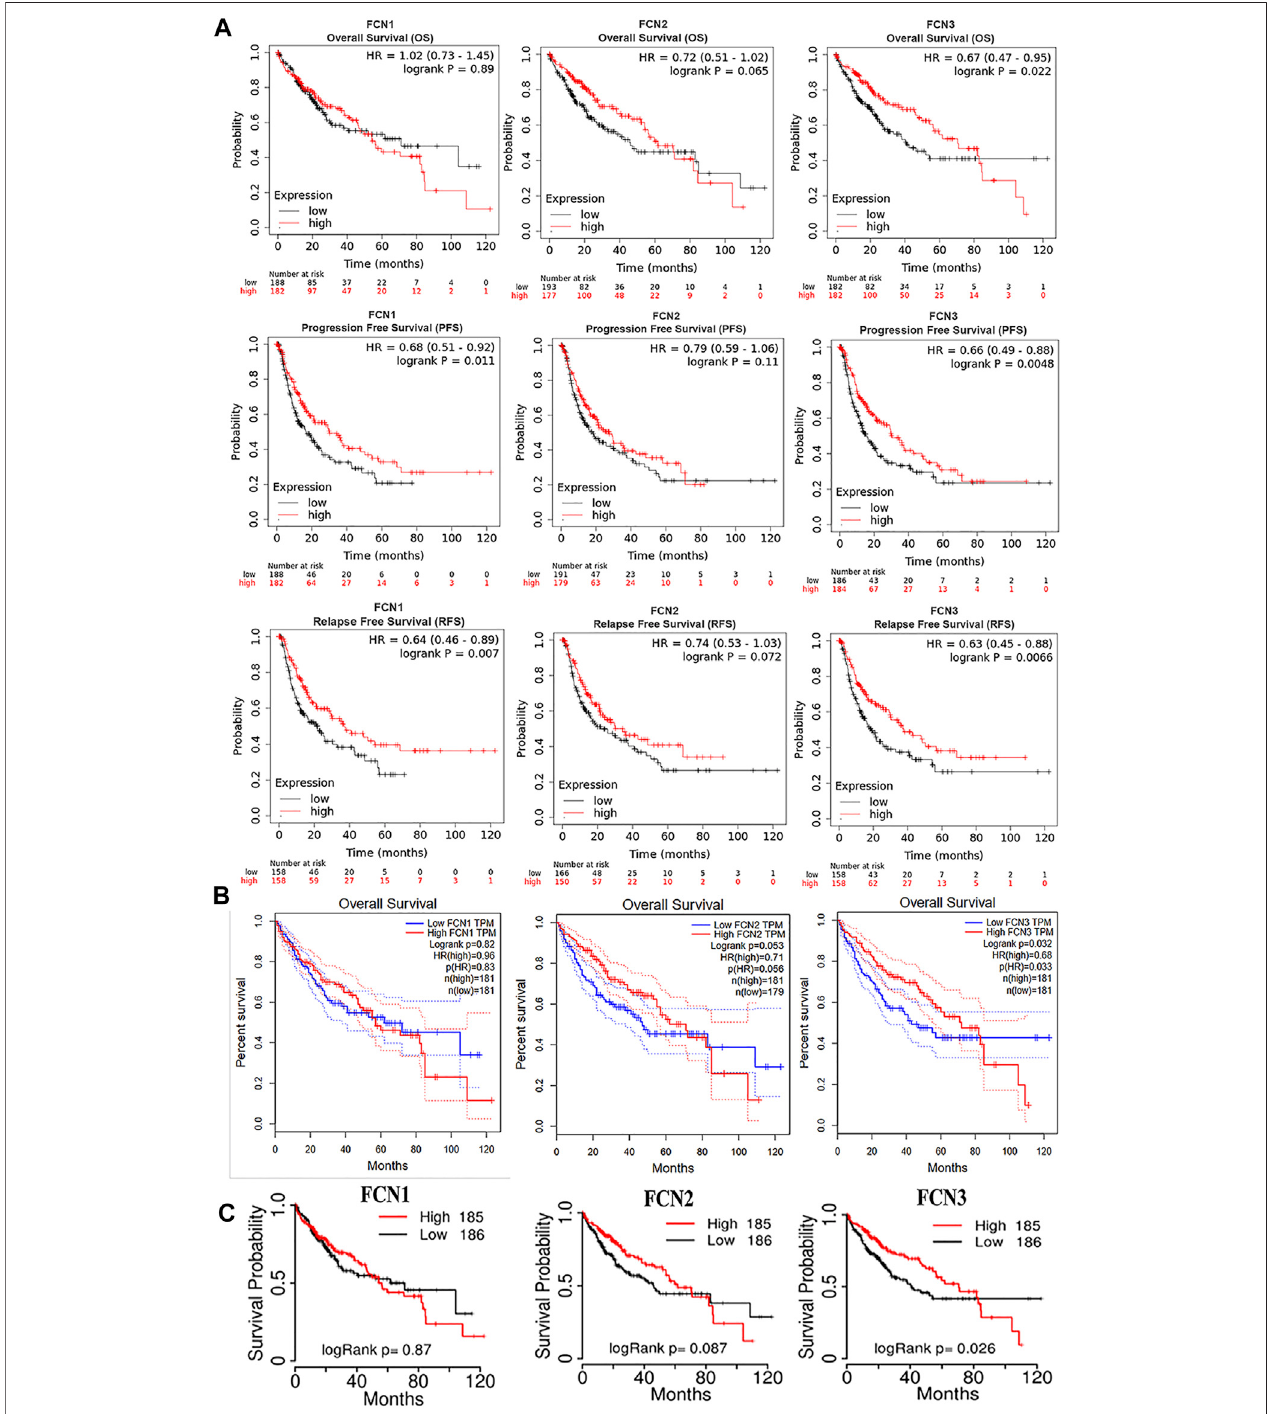
FIGURE 5 | The diagnostic and prognostic value of FCNs in LIHC. (A) Kaplan-Meier plotter reveals the overall survival (OS) progression free survival (PFS) and relaps-freesurvival(RFS)curvesbasedonthemRNAlevelsofFCNsinLIHCpatients. (B) Overallsurvival(OS)curvesofFCNsinLIHCpatientsdetermindusingGEPIA. (C) Overall survival (OS) curves of FCNs in LIHC patients determind using TCGAportal.